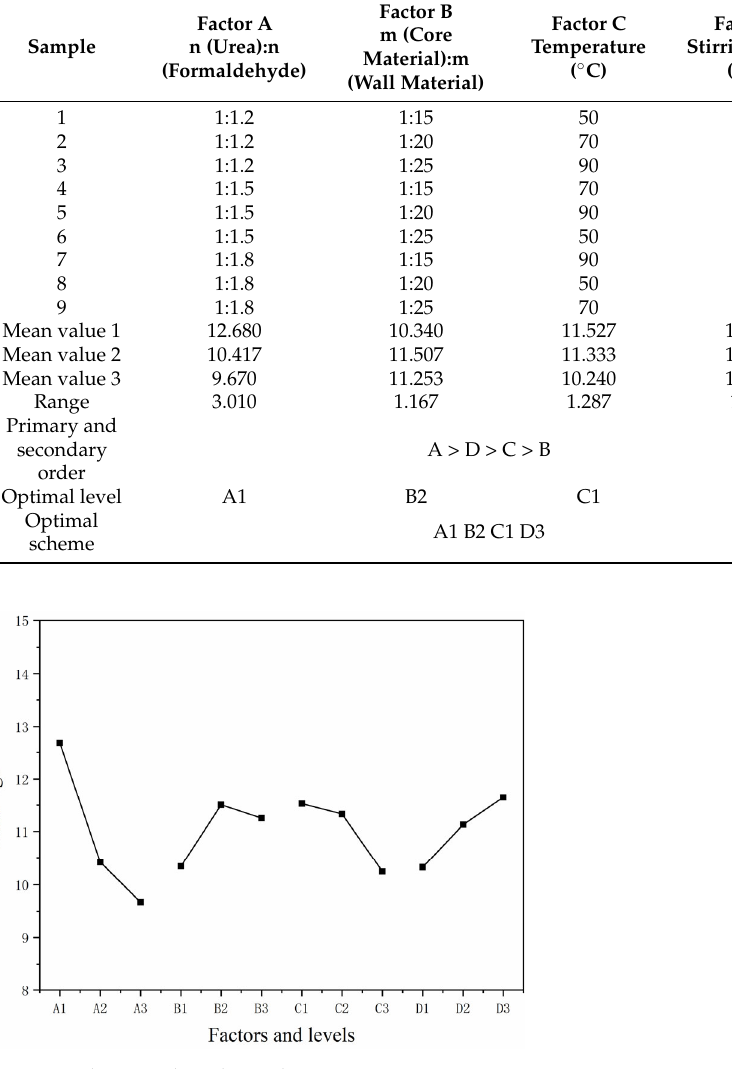
Figure 1. The visual analysis chart.